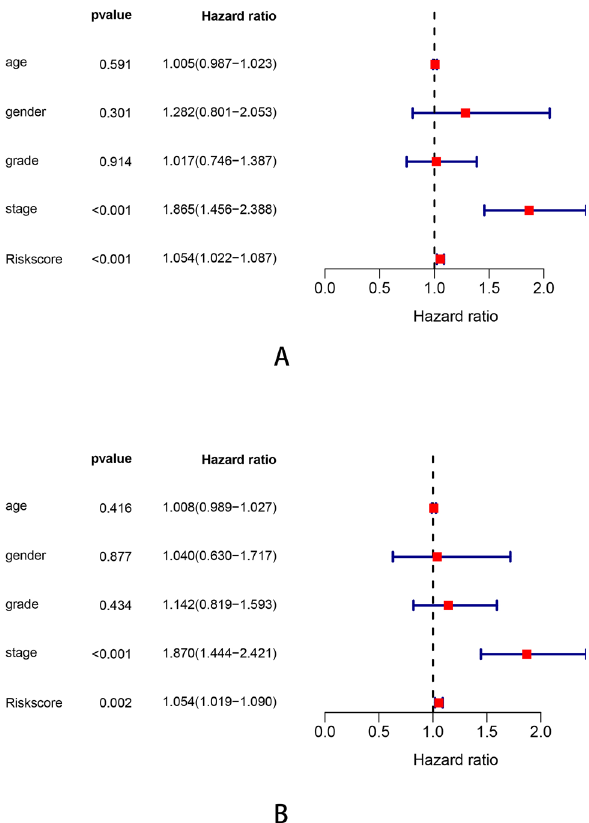
Figure 6. The univariate (A) and multivariate (B) Cox proportional hazards regression for Immune risk score and clinical